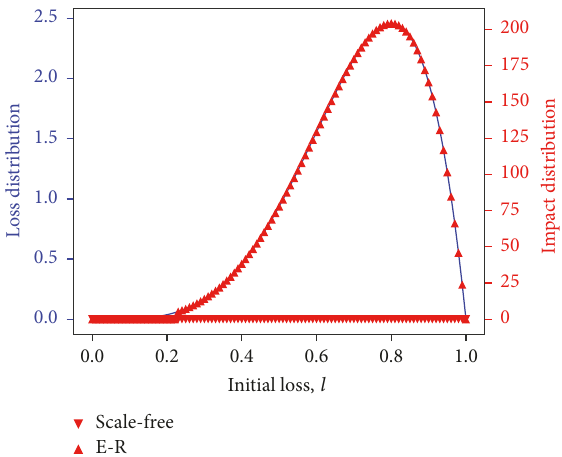
Scale-free E-R Figure 4: Initial loss and impact distributions for two directed acyclic graphs: a scale-free network (“scale-free”) and an Erd˝os- R´enyi network (“E-R”), in which the loss 𝑙 originates at node 𝑖 two nodes upstream of node 𝑗 and obeys a beta distribution ( 𝛼 = 5.0 , 𝛽 = 2.0 ).